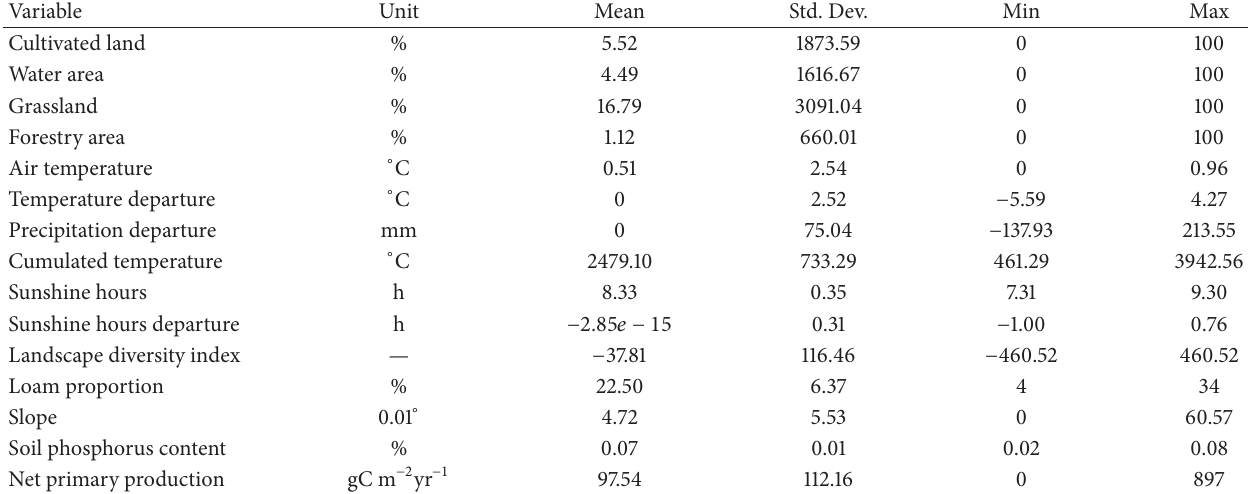
Table 2: Descriptive statistics of key ecosystem services indicators in the Heihe River